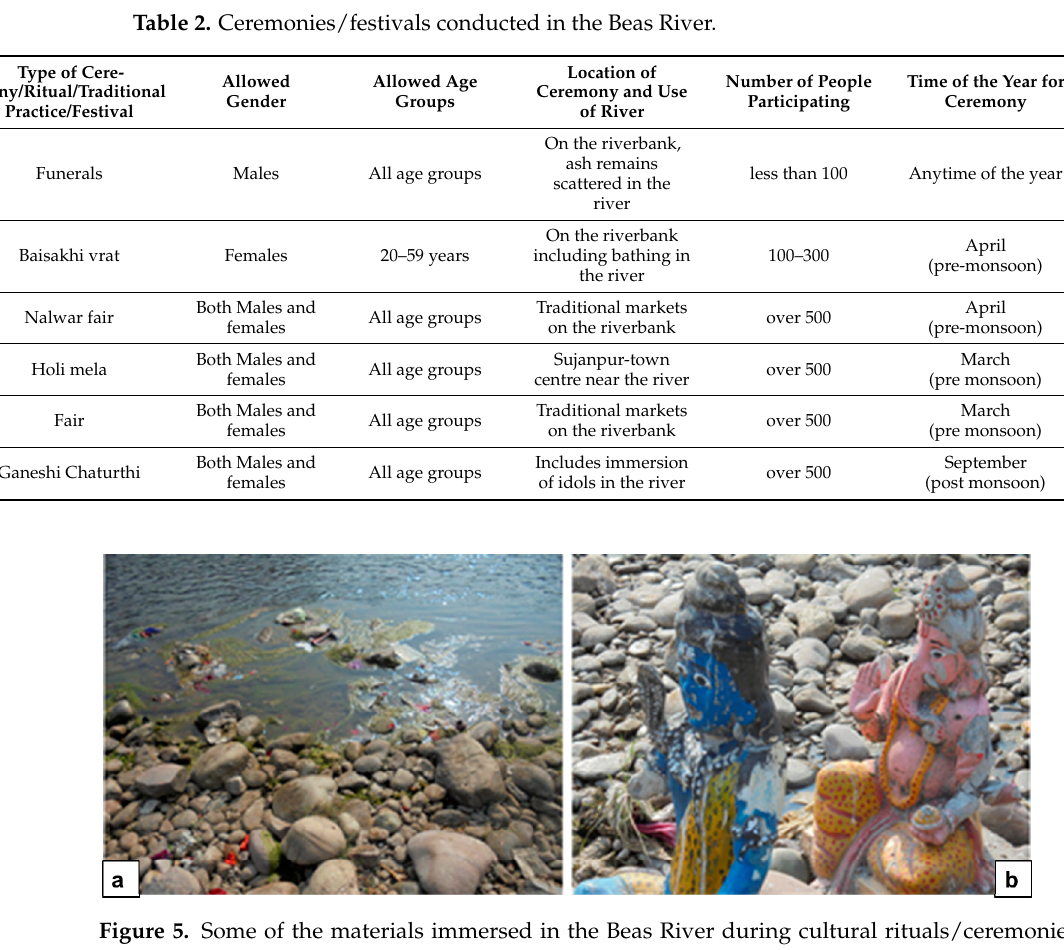
Figure 6. A funeral captured during the field visit in Sujanpur (source: lead author, 2017). 3.5. Changes in the Beas River Overtime and Associated Changes in CES All respondents from both study sites indicated that during the time they have lived in the study sites, they have witnessed changes in the Beas River. The most significant change mentioned by almost all respondents in both sites was the reduction of the river flows (Figure 7). This was attributed to construction of dams upstream, rainfall reduction and glacial area reduction. Another observed change, although not much frequently mentioned was the pollu- tion of the river with solid waste. Such accumulation of waste was partly attributed to religious ceremonies that involve immersion of materials into the river. These observed changes in the Beas River were also linked to changes in some CES. As shown in Figure 8, CES that have significantly decreased over time were aesthetic values, and recreation and tourism as indicated by most respondents. The majority of respondents in Sujanpur (93%) (Supplementary Material, S2) also indicated that educa- tional and ecological knowledge benefits of the Beas River have also decreased over time. As shown in the figure below, most respondents indicated that some CES have not changed over time. This particularly applies to those CES identified as absolutely essen- tial to local communities such as religious ceremonies, sense of place and identity and inspiration.